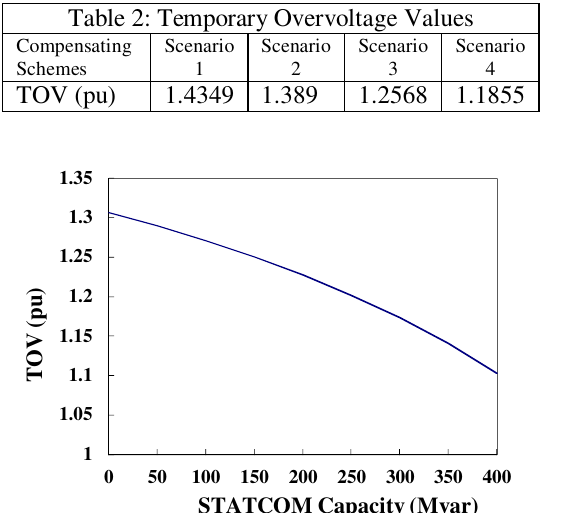
Table 2: Temporary Overvoltage Values